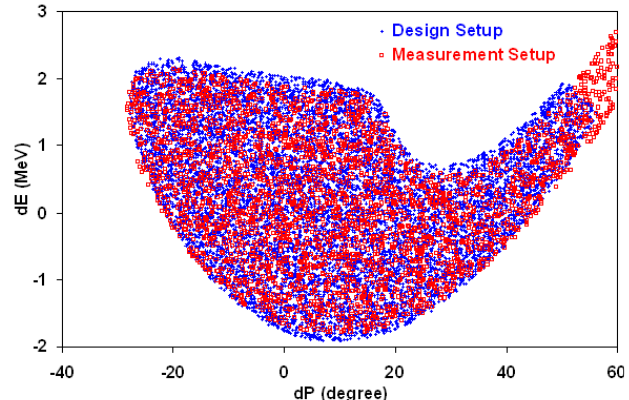
FIG. 4. (Color) Model longitudinal acceptance of the second cavity with the first cavity at the design phase (cid:1) 15 (cid:3) (Design setup) and at the measurement phase (cid:1) 90 (cid:3) (Measurement setup).